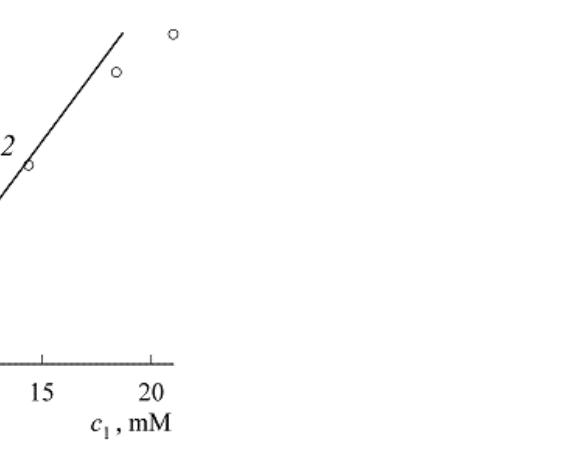
Figure 8. Solubilization curve for NR in premicellar solution (Section 1) and in SDS micelles (Sec- tion 2).